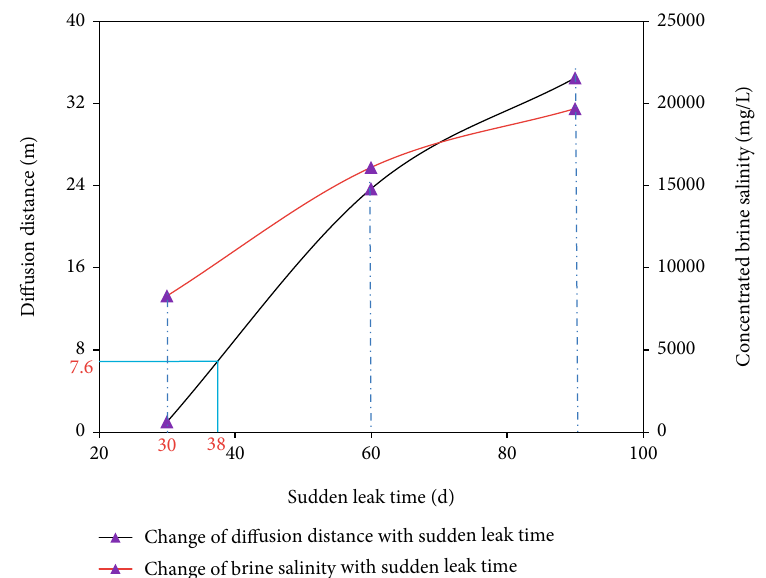
Figure 14: The relationship curve between the di ff usion distance and salinity of concentrated brine and di ff erent sudden leak time.